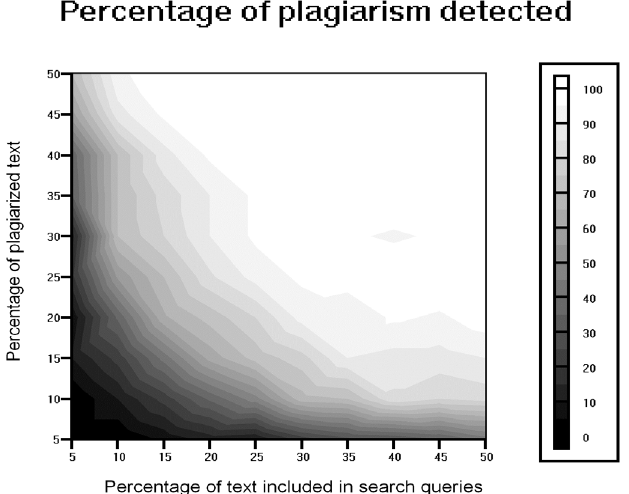
Figure 4 . Summary of the plagiarism detection